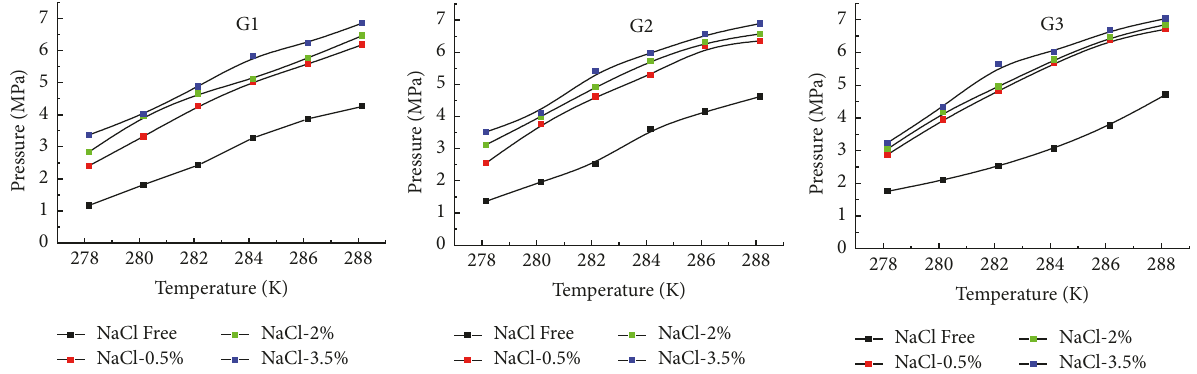
Figure 3: P-T curve of hydration reaction.